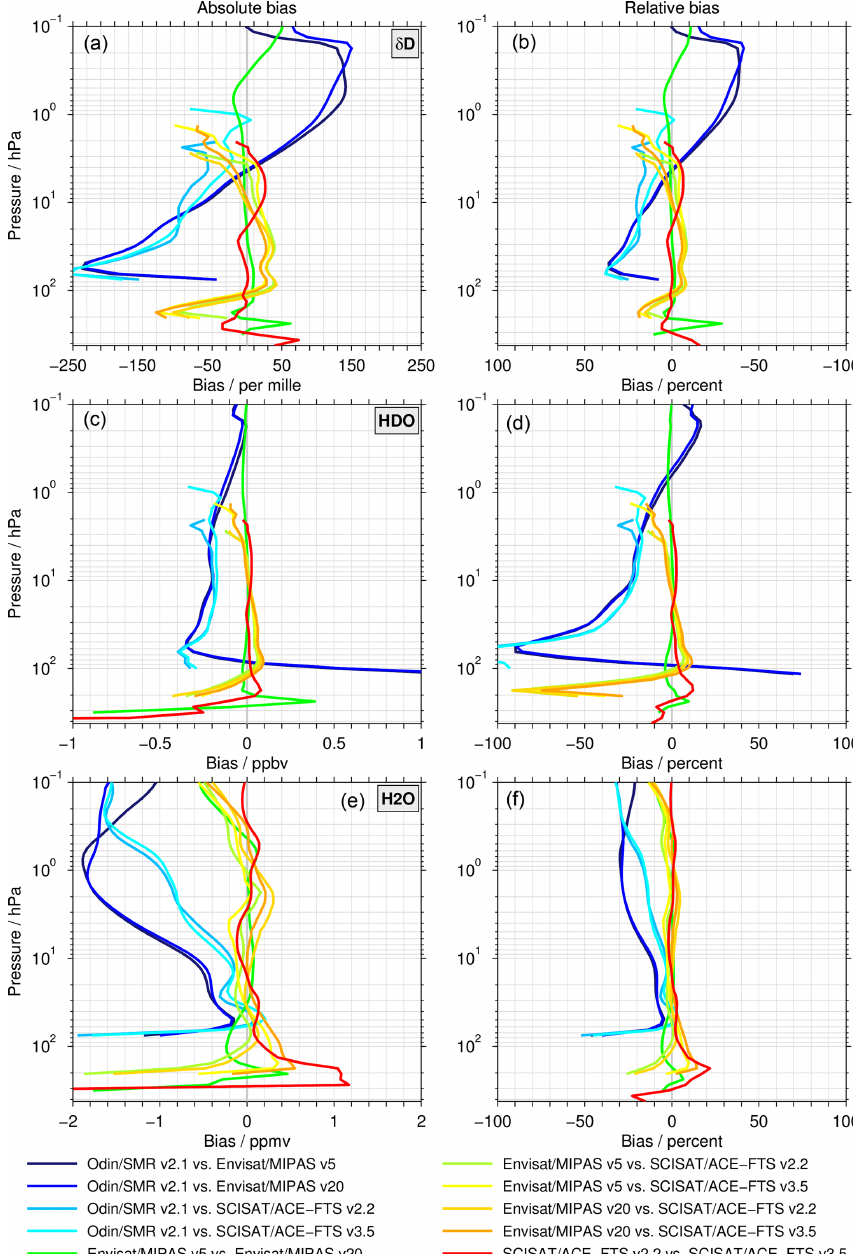
Figure 2. Profile-to-profile comparisons between all data sets for δ D (a, b) , HDO (c, d) , and H 2 O (e, f) . Panels (a, c, e) show the biases in absolute terms, whereas panels (b, d, f) show the relative biases. Please note that for the relative bias in δ D, (b) , the x axis has been reversed for visual consistency with the absolute